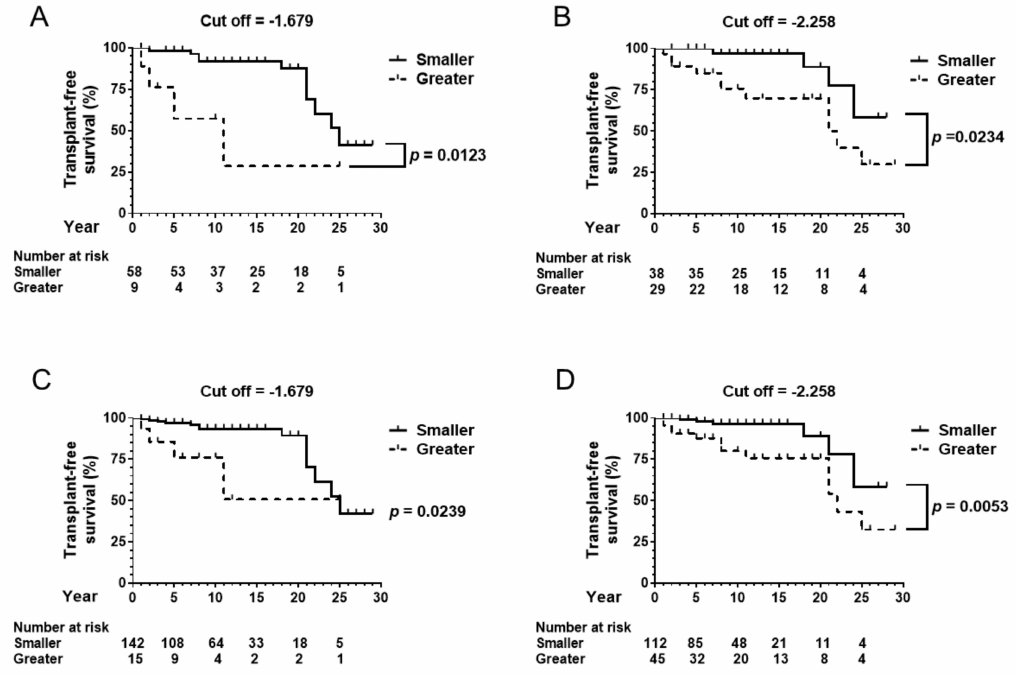
Figure 2. Transplant-free survival in the biopsy-proven cohort and the total cohort. ( A ) In the biopsy-proven cohort of 67 patients, the cut-o ff ALBI score of − 1.679 di ff erentiated the patients’ transplant-free survival. ( B ) The alternative cut-o ff value of − 2.258 also divided the cohort by transplant-freesurvival. ( C )Inthetotalcohortof157patientswhowerefollowedupforoneyearormore, the cut-o ff ALBI score of − 1.679 di ff erentiated the patients’ transplant-free survival. ( D ) The alternative cut-o ff value of − 2.258 also divided the cohort by transplant-free survival. ALBI,